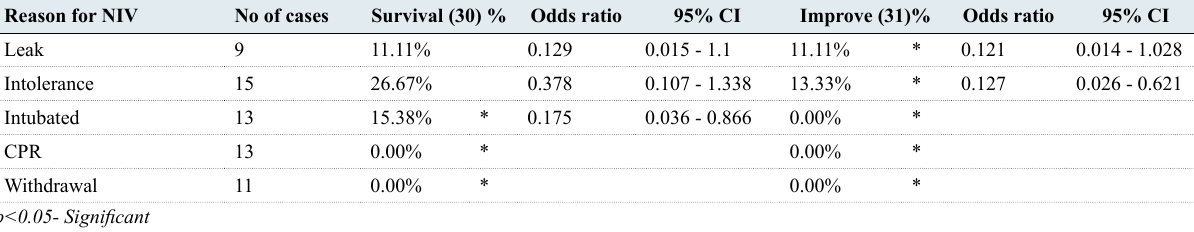
Table 4: Reasons for Non-Invasive Ventilation failure and their outcomes Reason for NIV No of cases Survival (30) % Odds